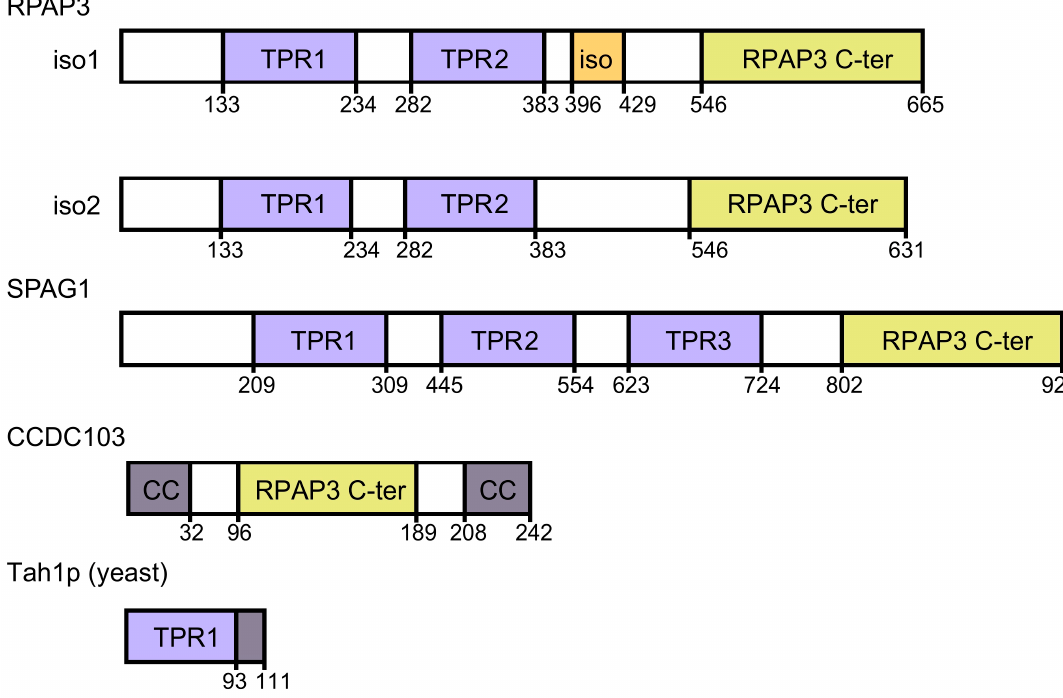
Figure 3. RPAP3 and homologous proteins. List of proteins homologous to human RPAP3. Homologous domains to the C-terminal domain of RPAP3 are labeled as RPAP3 C-ter. Iso1 and iso2 correspond to the two isoforms of RPAP3. The region in RPAP3 involved in binding to PIH1D1, present in isoform 1 but not in isoform 2, is labeled as “iso” (orange).